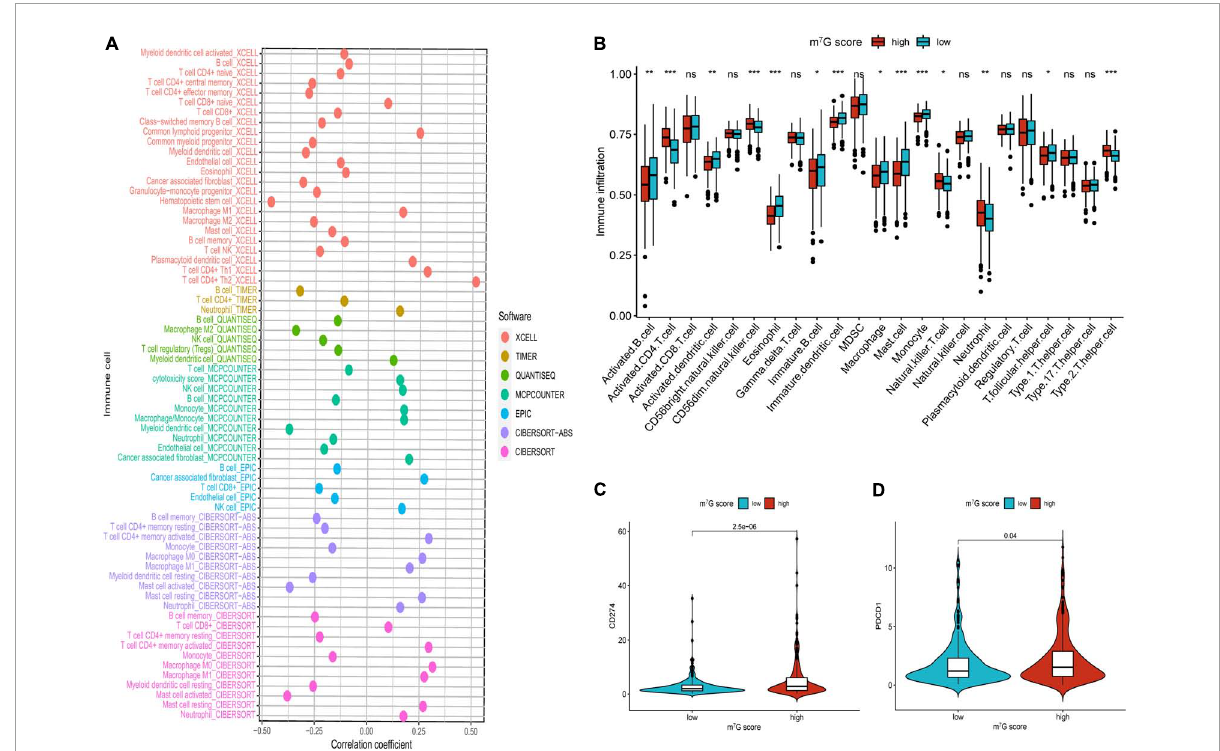
FIGURE11 Comparison of immune infiltration and immune checkpoints between high and low m 7 G score groups. (A) Correlation between immune cell and m 7 G score. On the right side of the correlation coefficient = 0 indicates a positive correlation with m 7 G score. (B) Immune infiltration analysis by ssGSEA. (C) Comparison of CD274 (PD-L1). (D) Comparison of PDCD1 (PD-1). * P < 0.05; ** P < 0.01; *** P <